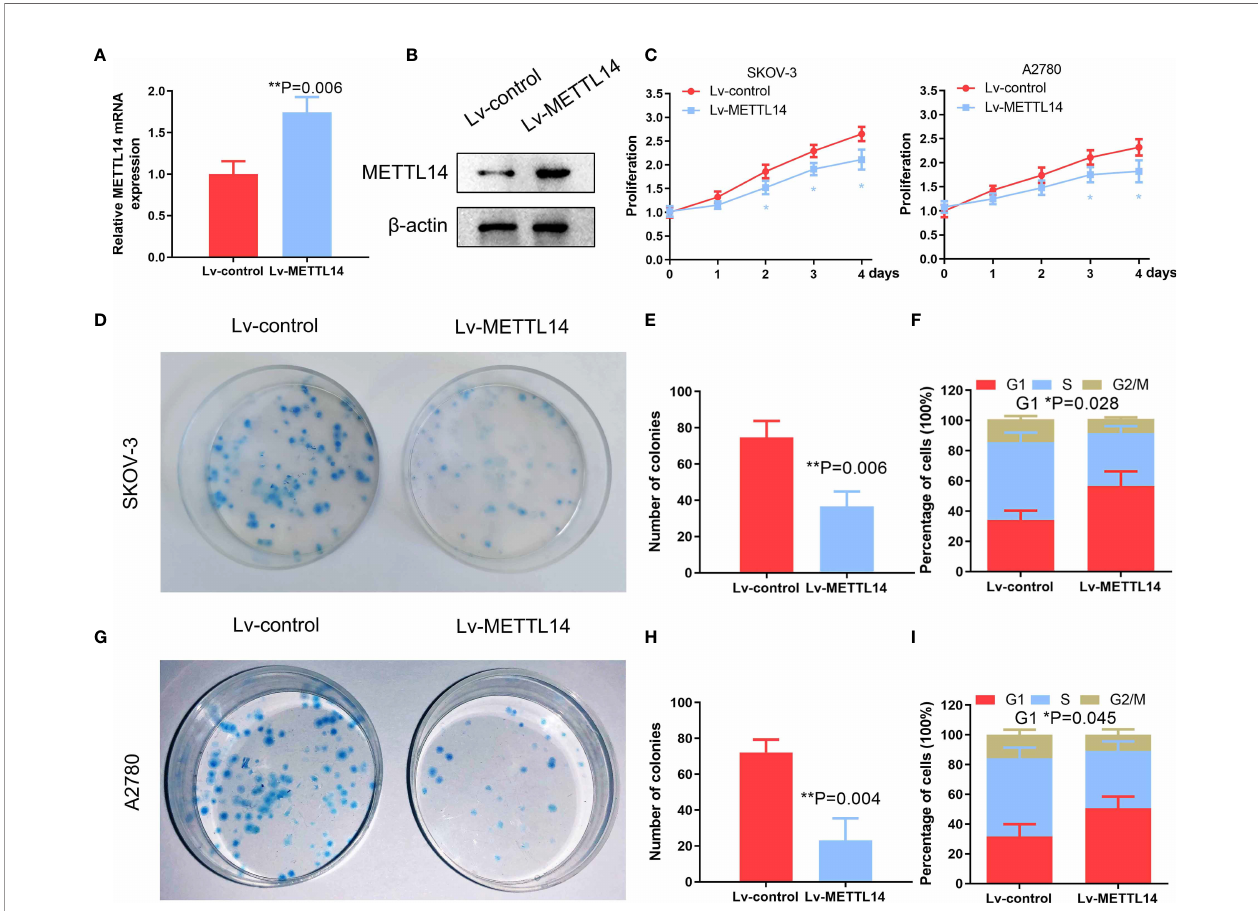
FIGURE 3 | Inhibitory effects of METTL14 overexpression by lentiviral transduction on ovarian cancer cell proliferation and colony formation. (A) METTL14 mRNA levels of ovarian cancer cells after transduction with Lv-control and Lv-METTL14 (** P = 0.006). (B) Western blot of METTL14 protein levels of ovarian cancer cells after transduction with Lv-control and Lv-METTL14. (C) Lv-control and Lv-METTL14 transduced SKOV-3 and A2780 cells were seeded into 96-well plates, cultured for 4 days, and then subjected to an MTS cell proliferation assay (* P < 0.05). (D, E) Lv-control and Lv-METTL14 transduced SKOV-3 cells were seeded into 3.5-cm plates, cultured for 14 days, and then subjected to a colony formation assay (** P = 0.006). (F) Lv-control and Lv-METTL14 transduced SKOV-3 cells were cultured in serum-free medium for 24 h, cultured in complete growth medium for an additional 16 h, and then collected for fl ow cytometry to determine cell cycle distribution (* P = 0.028). (G – I) Lv-control and Lv-METTL14 transduced A2780 cells, subjected to a colony formation assay (** P = 0.004) and cell cycle distribution. Bar graph displaying the percentages of cells within the G1, S, and G2/M phases (* P = 0.045). Graphical data represented as the mean ±